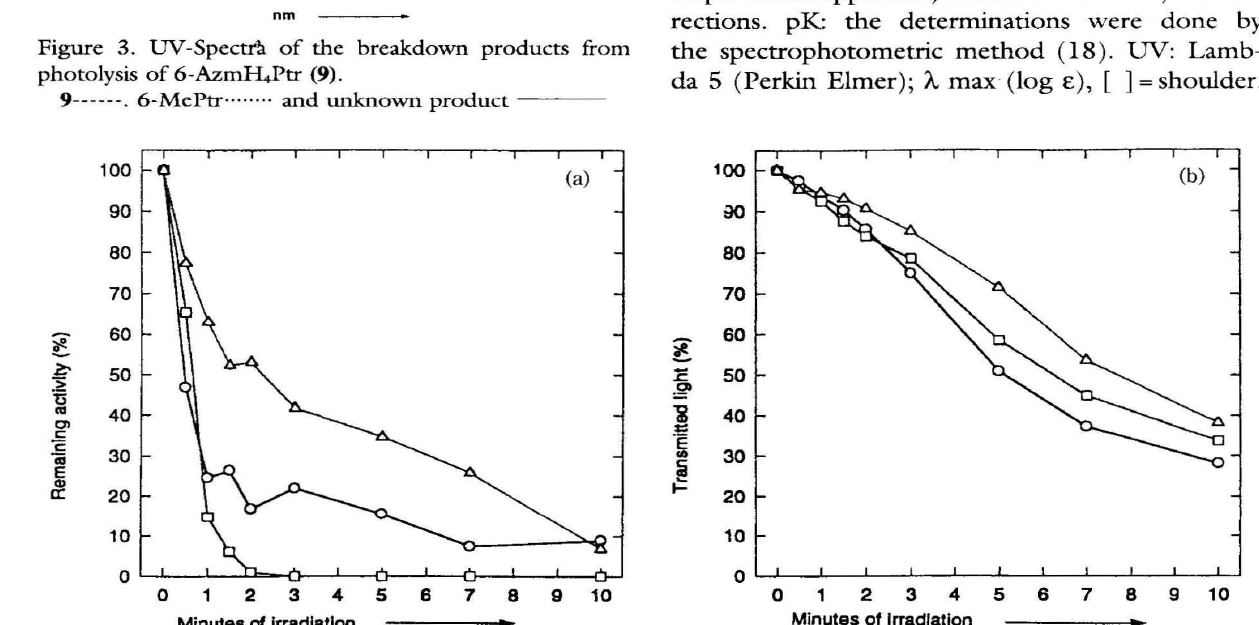
Figure 3. UV-Spectra of the breakdown products from photolysis of 6-Azm&Ptr (9).